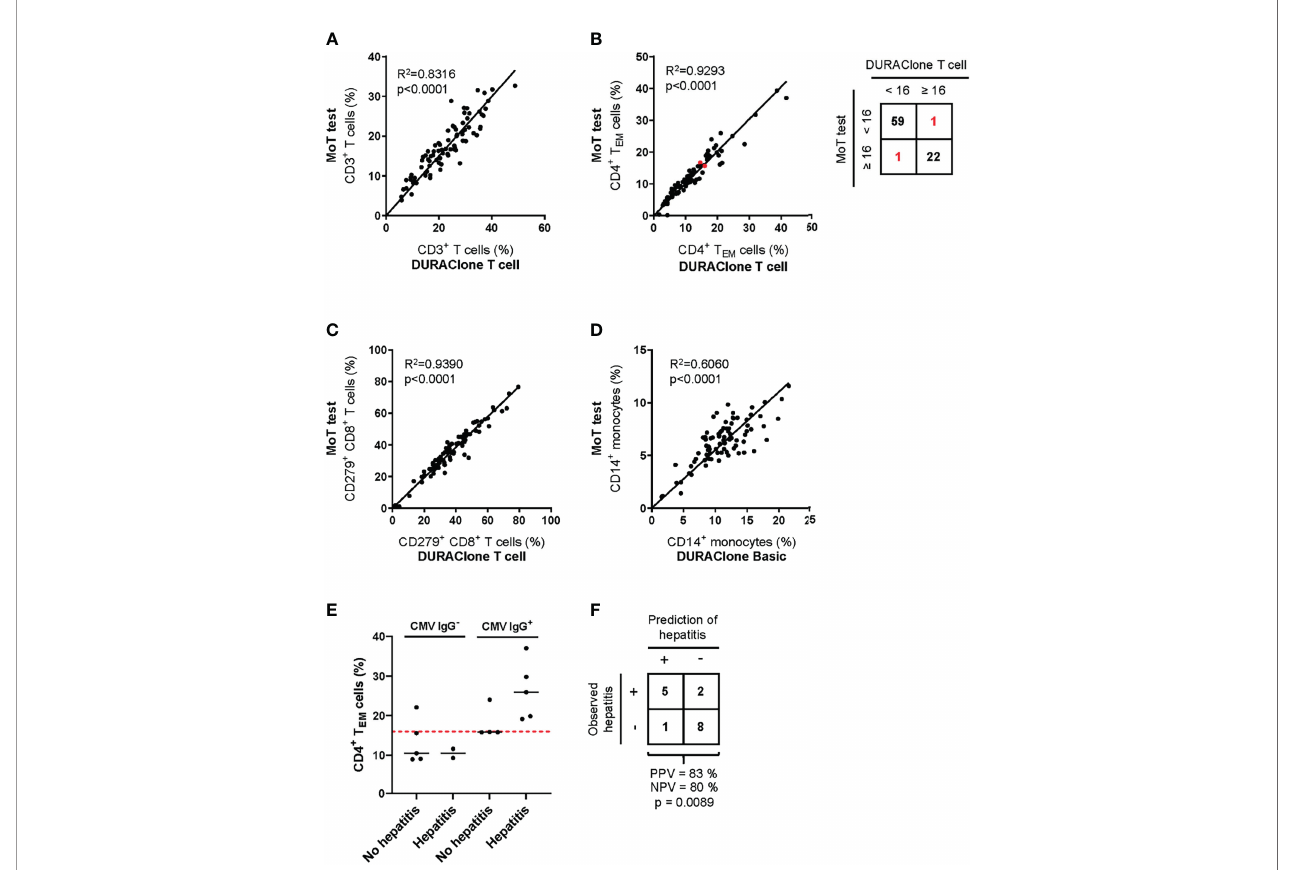
FIGURE 6 | Method comparison of MoT test and DURAClone IM Tubes. Fresh whole blood EDTA samples from patients with stage II (n = 52), stage III (n = 11) or stage IV (n = 20) melanoma were investigated using the MoT test, the DURAClone IM Phenotyping Basic Tube and the DURAClone IM T cell subsets Tube. Frequencies of CD3 + T cells (A) , CD4 + T EM cells (B), CD279 + CD8 + T cells (C) and CD14 + monocytes (D) were determined. The alternative methods differently classi fi ed only two samples with borderline CD4 + T EM cell frequencies (marked in red; method concordance of 98%). Fresh whole EDTA blood of stage IV melanoma patients (n = 16) was analyzed prior to checkpoint inhibitor treatment using the MoT test. (E) CMV serology status was determined and the development of immune- related hepatitis was evaluated within 12 weeks post therapy start. Dashed red line indicates a cut-off of CD4 + T EM ≥ 16%. Median values are indicated by a black line. (F) Classi fi cation of stage IV melanoma who did or did not develop immune-related hepatitis. Development of hepatitis was correctly predicted in 5 of 6 cases (PPV = 83%). 2 of 10 patients who developed hepatitis were incorrectly classi fi ed as hepatitis negative (NPV = 80%) (p = 0.0089, two-way ANOVA